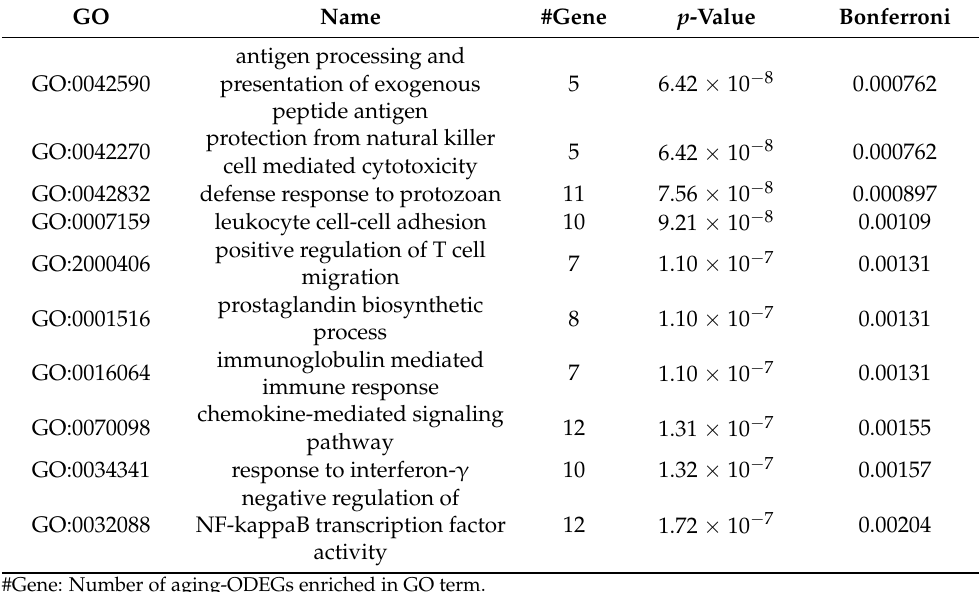
Table 2. Top 10 GO terms enriched by aging-ODEGs.